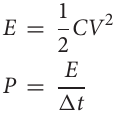
Frontiers in Chemistry |